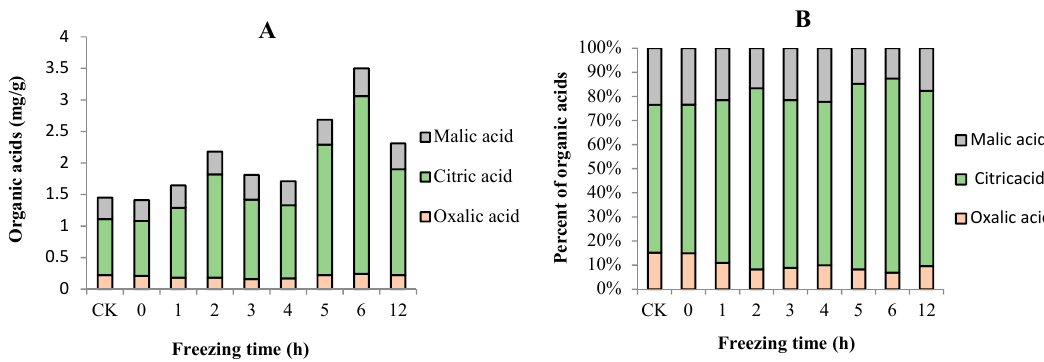
Figure 9. Changes in total organic acid content ( A ) and percentage composition of organic acids ( B ) in “Ruaner” pear during the freezing–thawing stage.